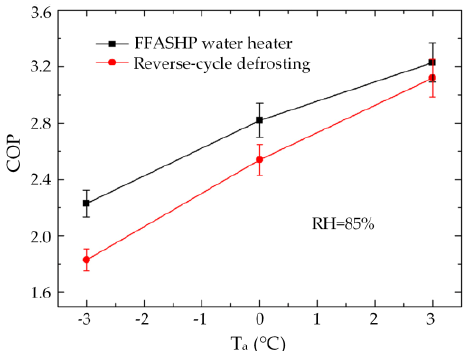
Figure 28. Comparison of the COP between FFASHP water heater system and reverse-cycle defrosting system at different ambient air temperatures [10].